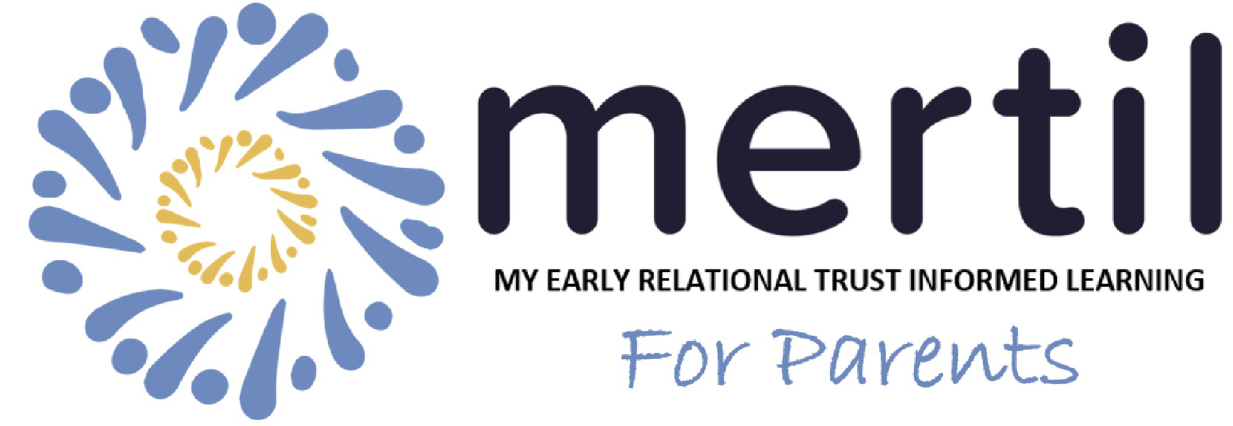
Fig 1. MERTIL for Parents